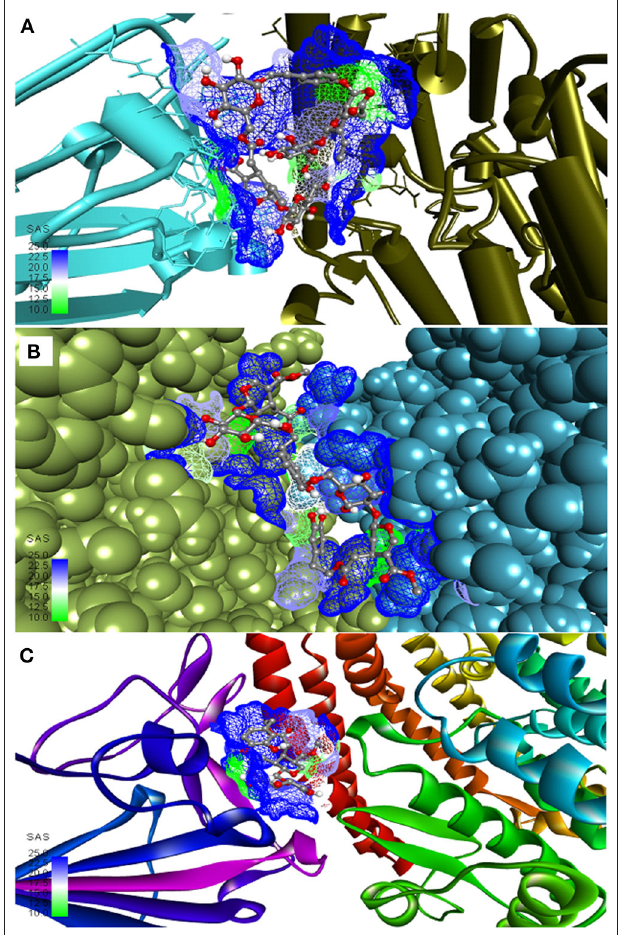
FIGURE 2 | Intermolecular interactions of (A) Nüzhenide oleoside (B) Oleuropein dimer (C) Dihydro oleuropein with SARS-CoV-2 spike protein-ACE-2 interface residues. Interaction with Lys417 of the spike protein is considered crucial for inhibition. Nature of bonds: black—hydrogen bonds; yellow—attractive charge; brown— π -alkyl; blue—alkyl-alkyl